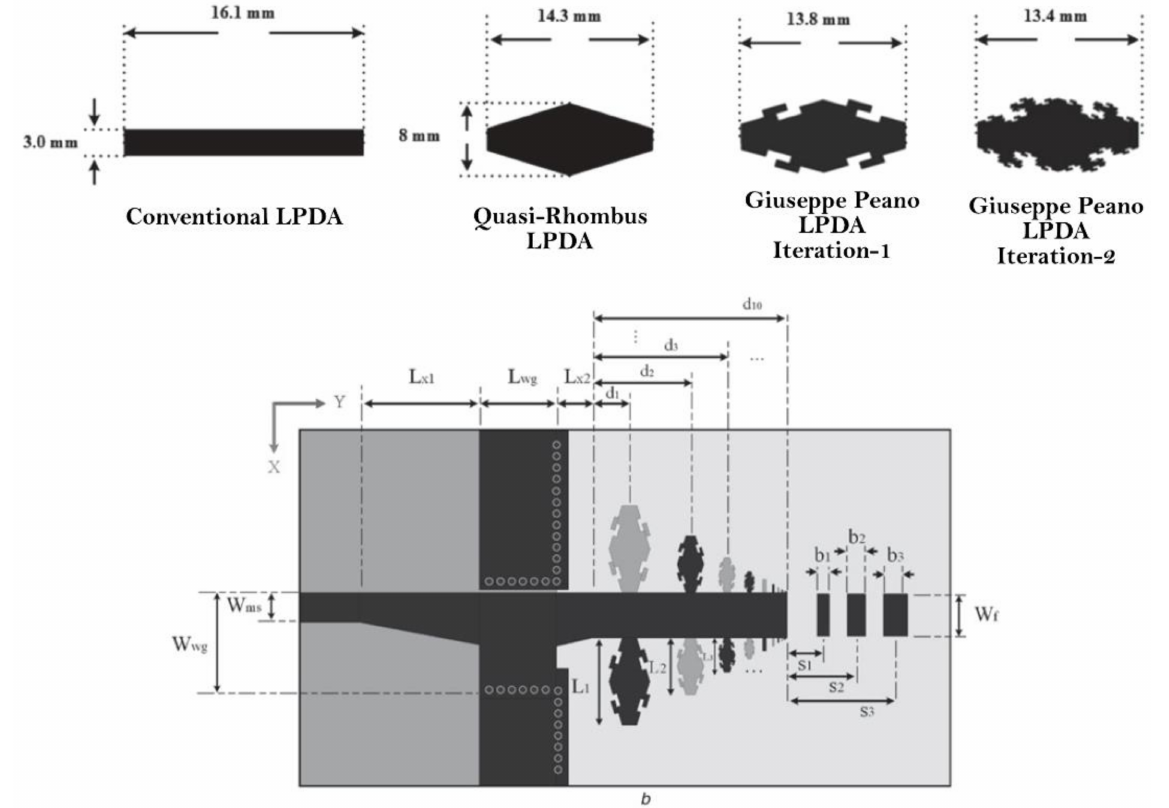
Figure 4. PLPDA design with rhombic dipoles terminated using Peano fractals in [33].